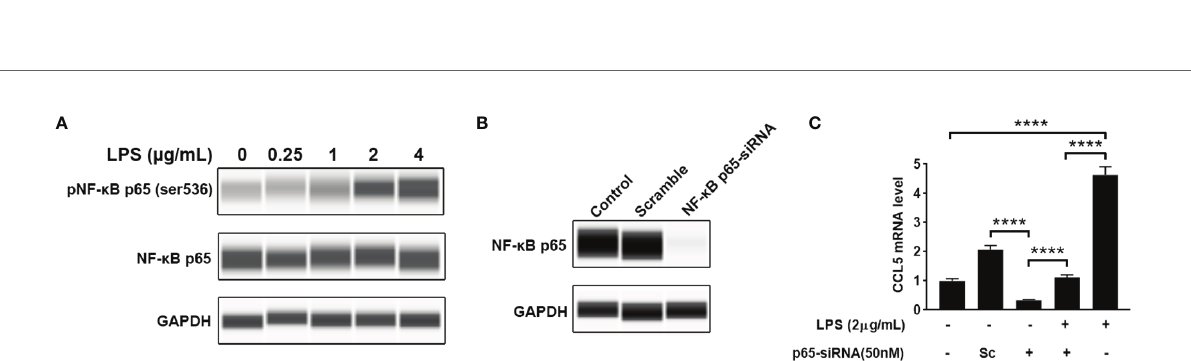
FIGURE 4 | LPS induces the release of CCL5 from microglia through activation of mTOR signaling. HMC3 cells were treated with LPS (0-8 µg/mL) for 48 h, and the expression of CCL5 and activity of mTOR signaling were assessed. (A) Release of CCL5 was measured by quantitative ELISA test (n=3 each group). (B) The total and phosphorylated levels of mTOR were analyzed by Western blotting with GAPDH as loading control. (C) Release of CCL5 was measured by ELISA (n=3 each group). HMC3 cells were co-incubated with LPS (2 µg/mL) and rapamycin (400nM) for 48 h Data are presented as mean ± SD. Statistical signi fi cance was determined by Student- t test and denoted by ** p < 0.01 and *** p < 0.001.